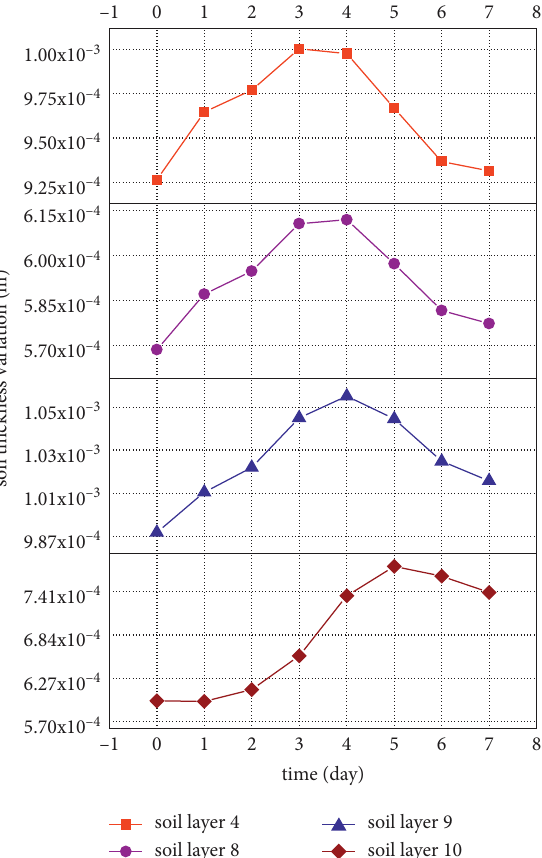
Figure 18: Time-course curve of the change in soil thickness in the center of the embankment.